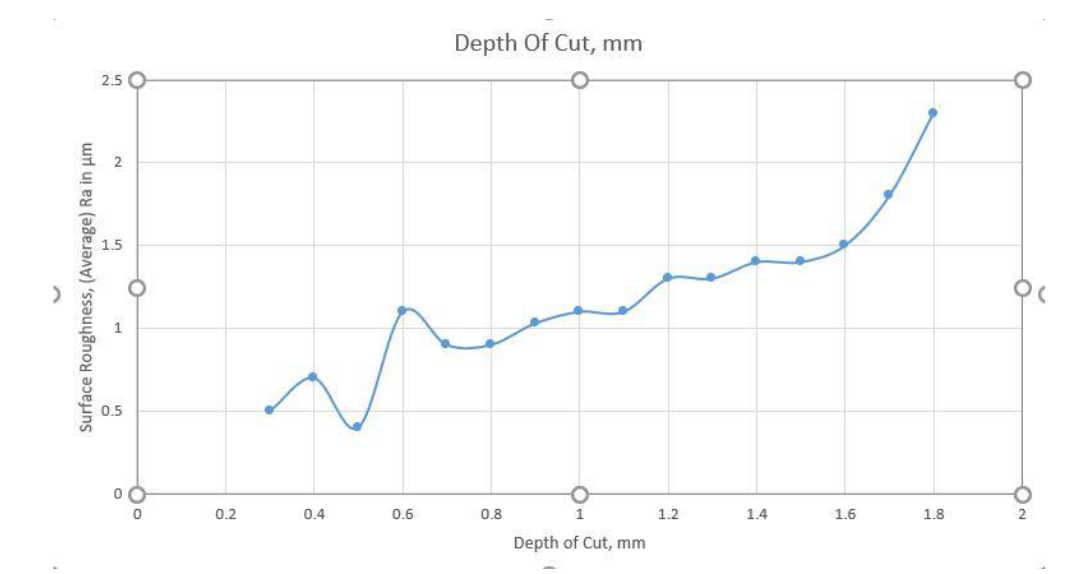
Figure 8: Depth of cut and R a graph (f = 0.055 mm/rev, v = 80 m/min kept